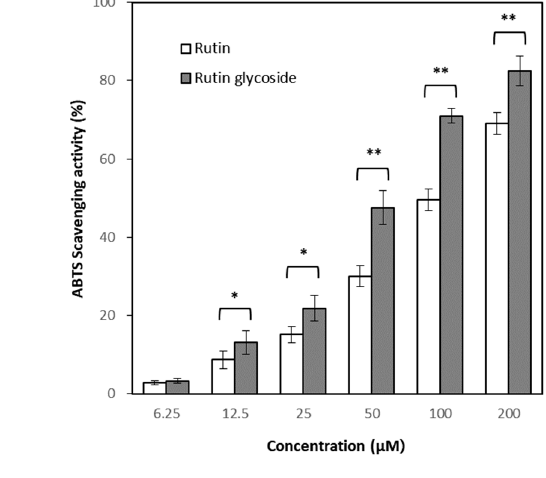
Table 1. Octanol/water partition coefficients of rutin and rutin glycosides.